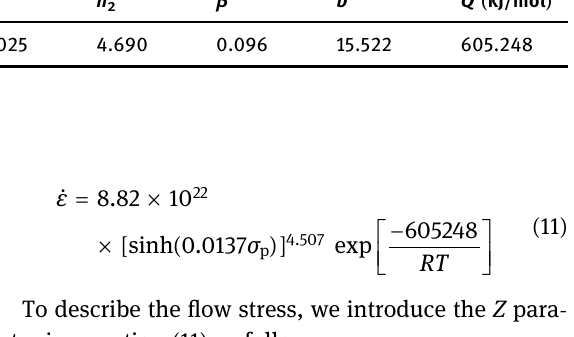
Table 3: Hot deformation parameters of the studied 9Cr3W3Co - ODS steels n n β b Q ( kJ/mol 1 2